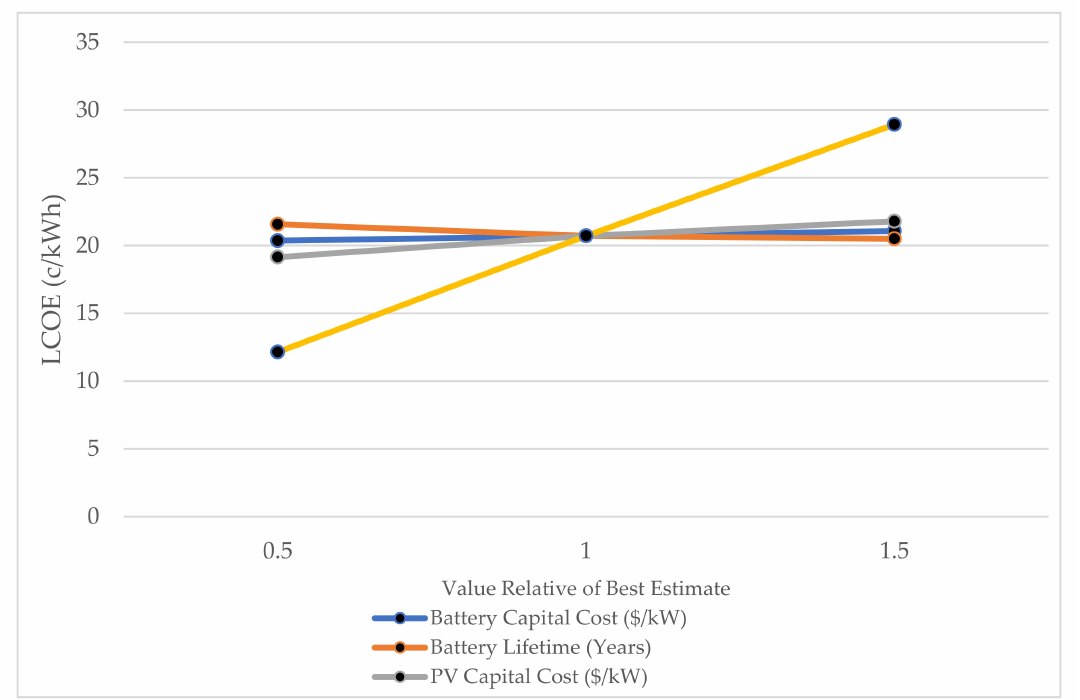
Figure 17. Sensitivity Analysis of PV Hybrid.